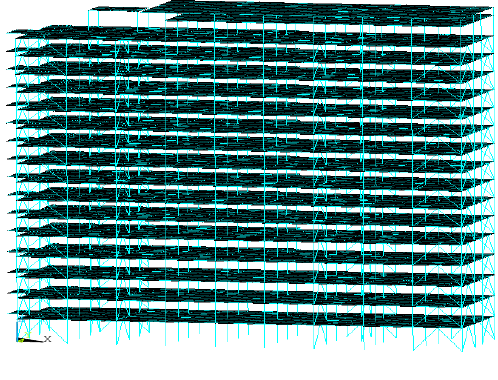
Figure 15. Global FE model. Table 6. Description of FAT36 curve.